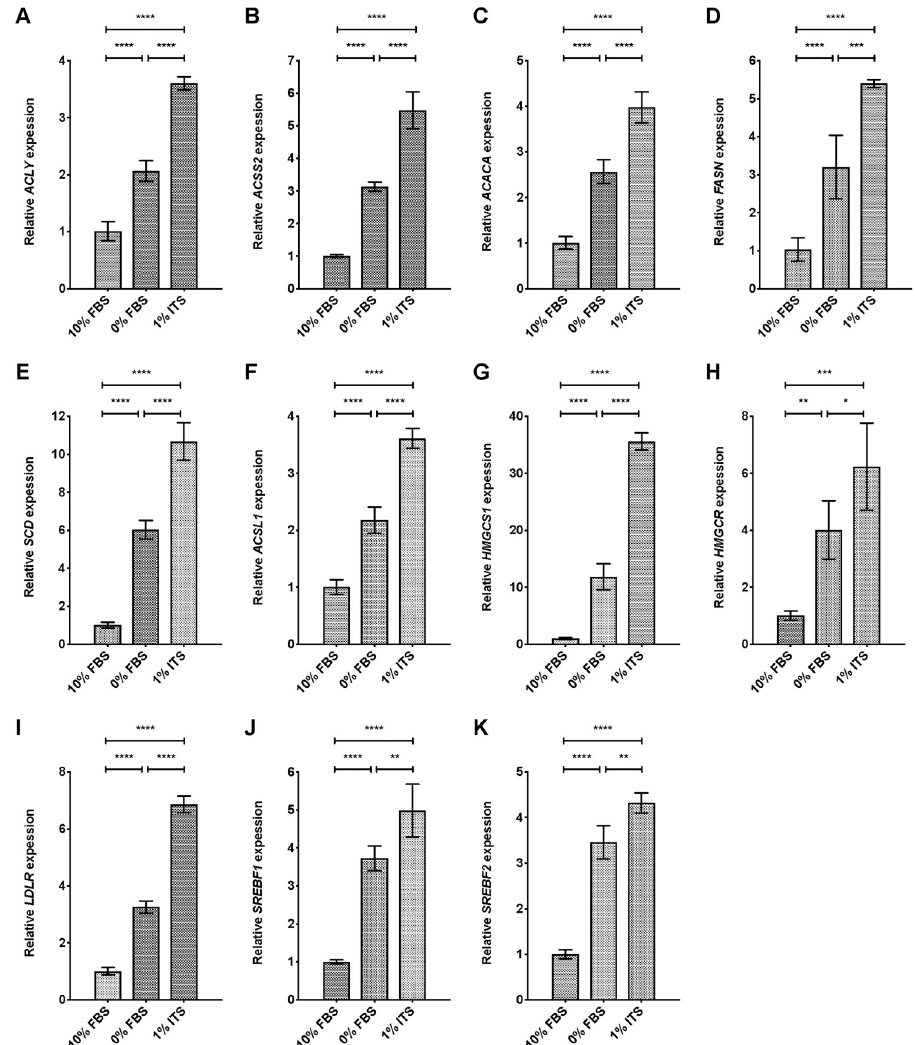
Tukey’s multiple comparison tests. ns, not significant. Each data point represents the mean ± SD of results from quadruplicate